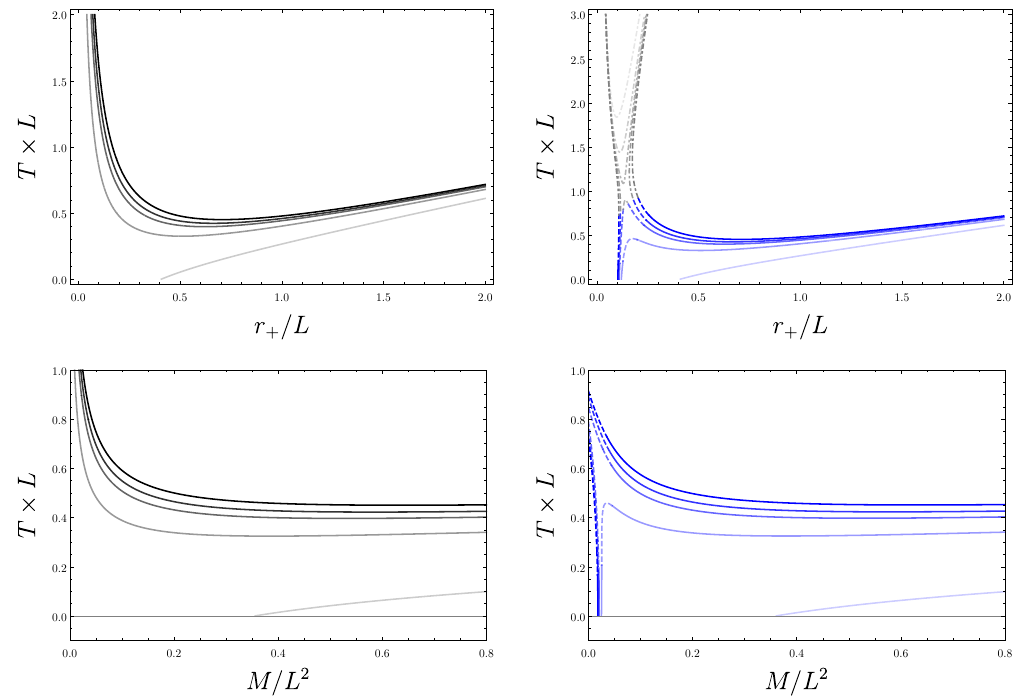
Figure 11 . Five-dimensional black hole properties in grand canonical ensemble I . Top Left : a plot of the temperature vs. horizon radius in Einstein gravity for Φ = 0 , 0 . 6 , 0 . 82 , 1 . 2 , 2 . 0 in order of decreasing opacity (or top to bottom through a vertical slice of the plot). Top Right : temperature 3 for the same values of the potential. In this = 10 vs. horizon radius in the cubic theory with µ/µ − c case, the dashed blue lines indicate negative Wald entropy, while the dot-dashed grey lines indicate negative mass (and hence the full solution does not exist). Bottom Left : the same situation as the top left plot, but now we replace the horizon radius with the mass. Bottom Right : the same situation as the top right plot, but now we replace the horizon radius with the